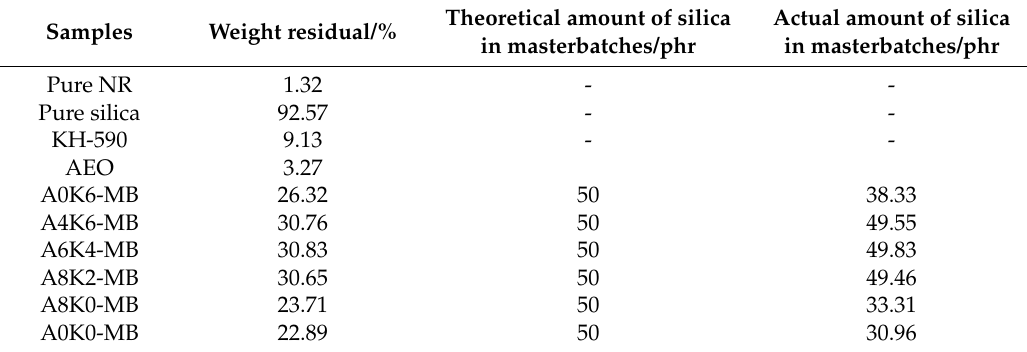
Table 5. Weight losses of six kinds of silica/NR master batches.